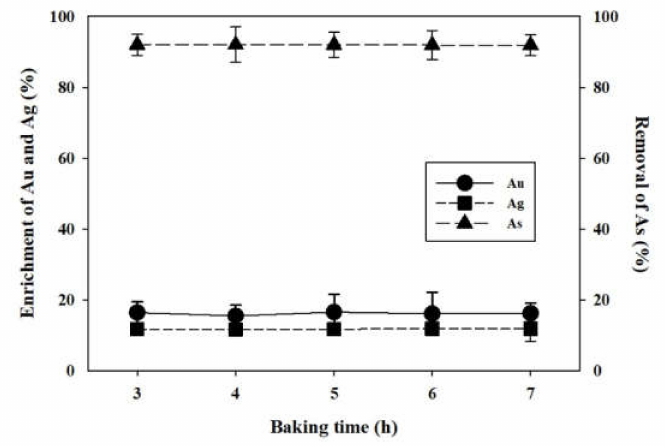
Figure 12. The removal of As and the enrichments of Au and Ag on the solid residue from hot water leaching. Conditions: baking temperature, 400 ◦ C; H 2 SO 4 concentration, 1.0 mL; and baking time, 3, 4, 5, 6, 7